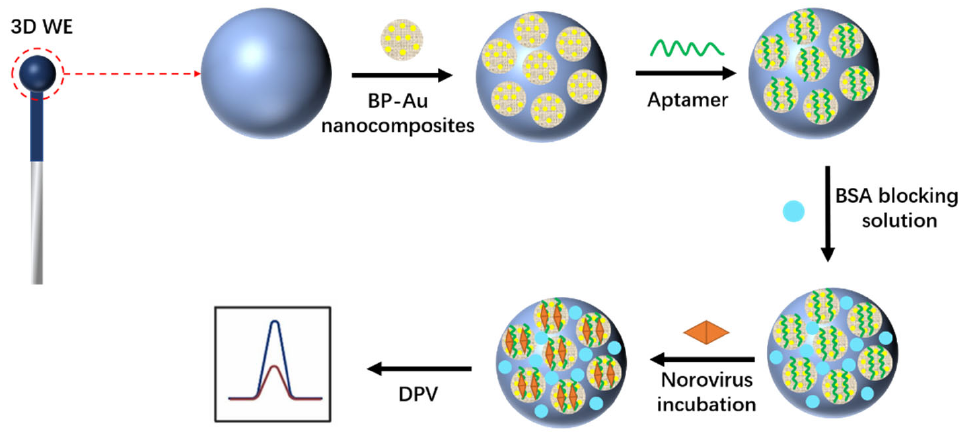
Figure 10. Schematic of a 3D electrochemical aptamer sensor for the detection of norovirus (Adapted with permission from Ref. [32]. 2022, Jiang et al.). Table 2. Electrochemical biosensors for virus detection.